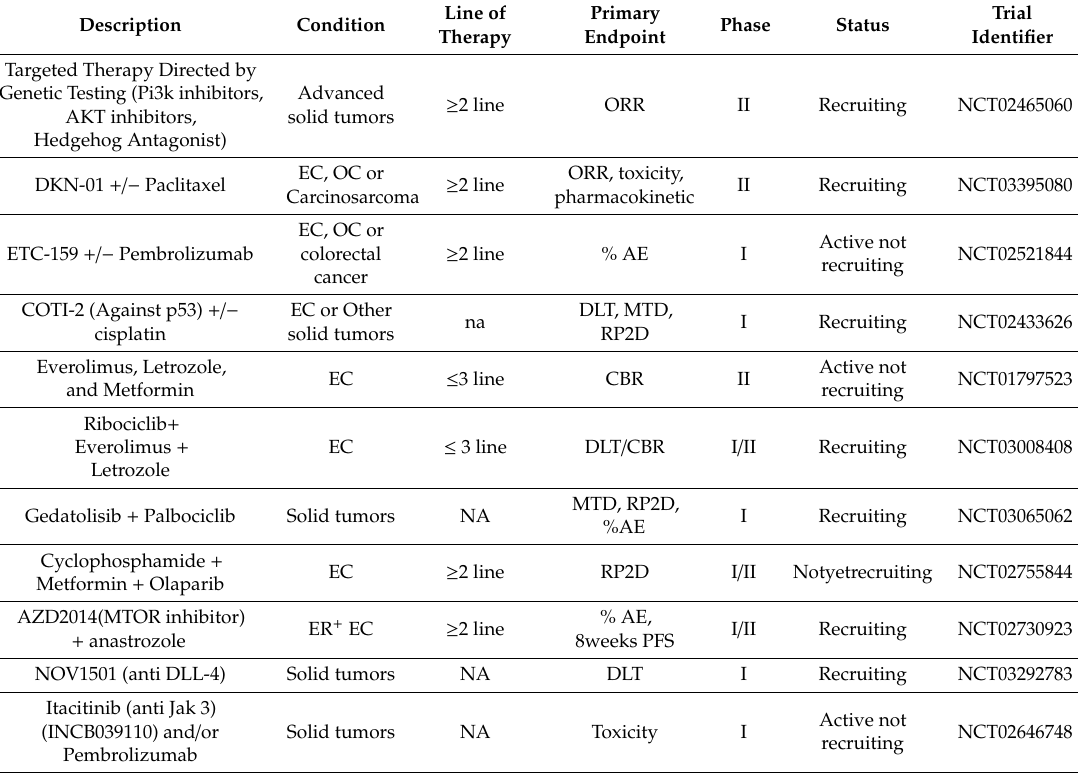
Table 1. Ongoing clinical trials targeting Cancer Stem Cells (CSCs) in Endometrial